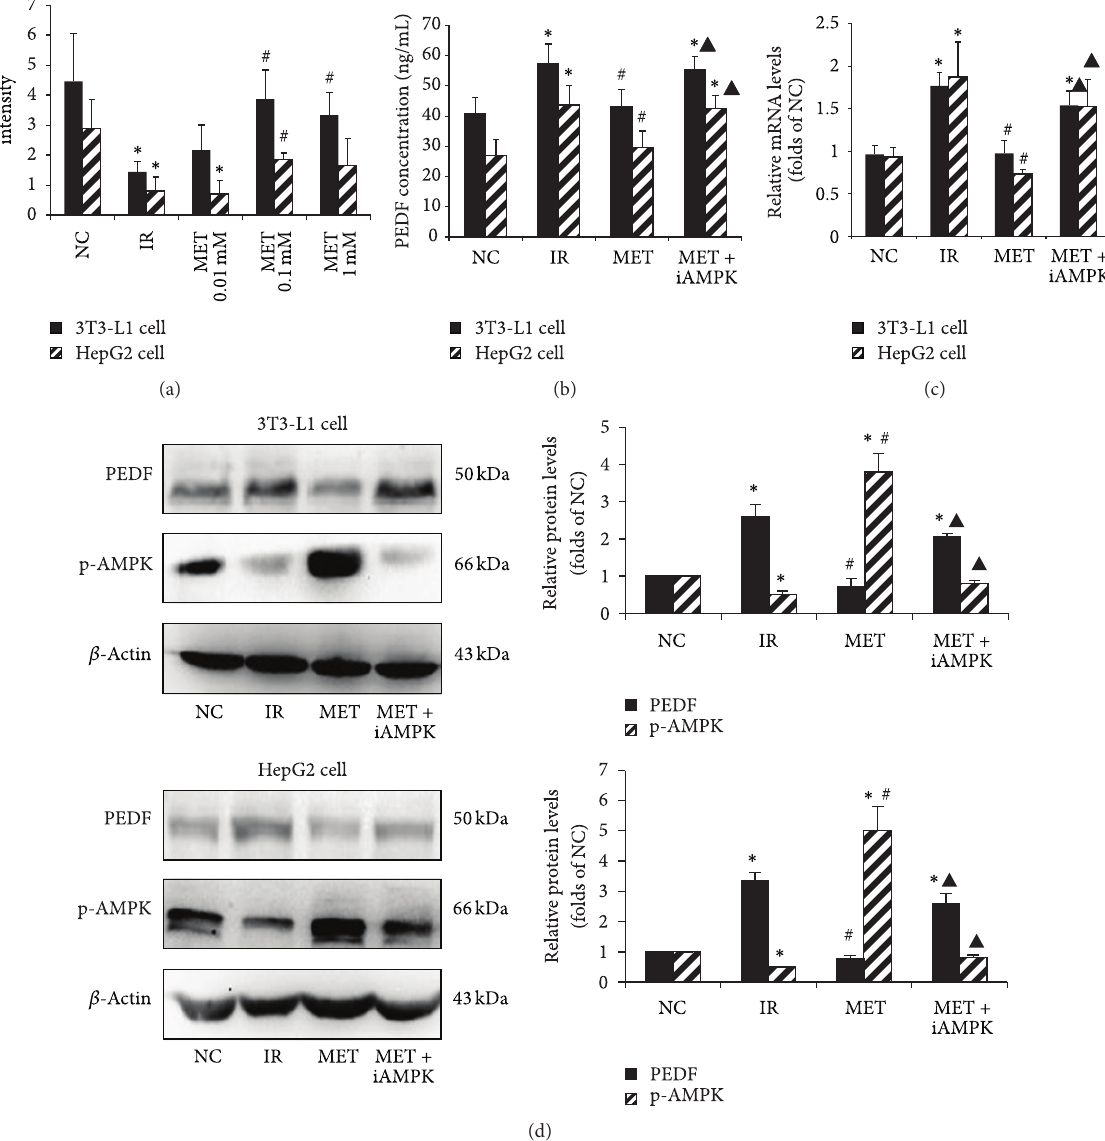
Figure 4: The effects of metformin on the secretion and expression of PEDF during IR improvement in vitro. (a) IR models of 3T3-L1 cell and HepG2 cell were treated with metformin (0.01, 0.1, and 1mM) for 24 h, and 2-NBDG uptake was examined. Finally, 0.1mM metformin was chosen for later experiments. (b) Supernatants of the cells were collected, and PEDF concentrations were determined by ELISA. (c) RT-PCR assay results of PEDF mRNA levels. (d) Western blot analysis of PEDF protein expression and phosphorylation of AMPK. The histogram represents mean ± SD of the densitometric scans for protein bands from three experiments, normalized by comparison with 𝛽 - actinandexpressedasapercentageofcontrol.NC:normalcontrol;IR:insulinresistance;MET:metformin;iA:inhibitorofAMPK. ∗ 𝑃 < 0.05 , compared with NC group. # 𝑃 < 0.05 , compared with IR group. 󳵳 𝑃 < 0.05 , compared with MET